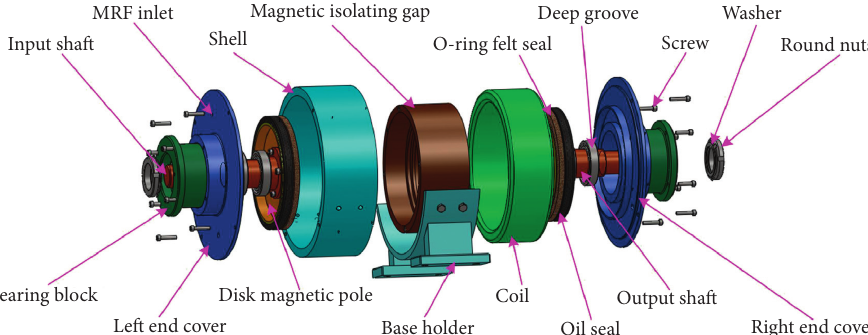
Figure 6: Explosive view of testing device.